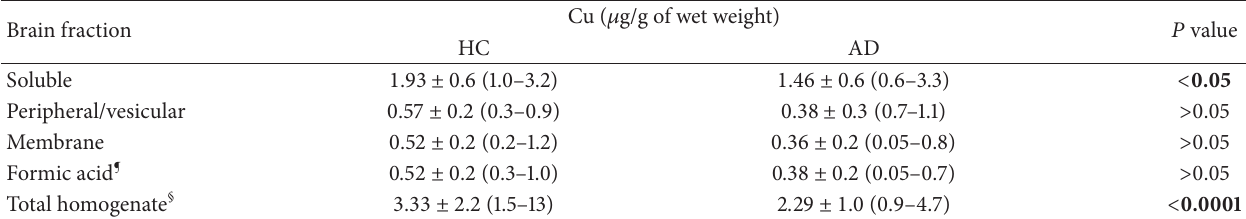
Table 1: Distribution of Cu in different cellular fractions and total levels from human brain.